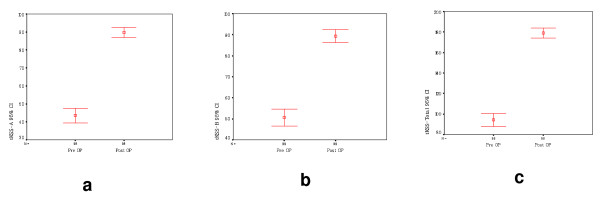
The error-bar graph illustrating the tKSS-A, tKSS-B, and tKSS-Total scores (95% confidence intervals).